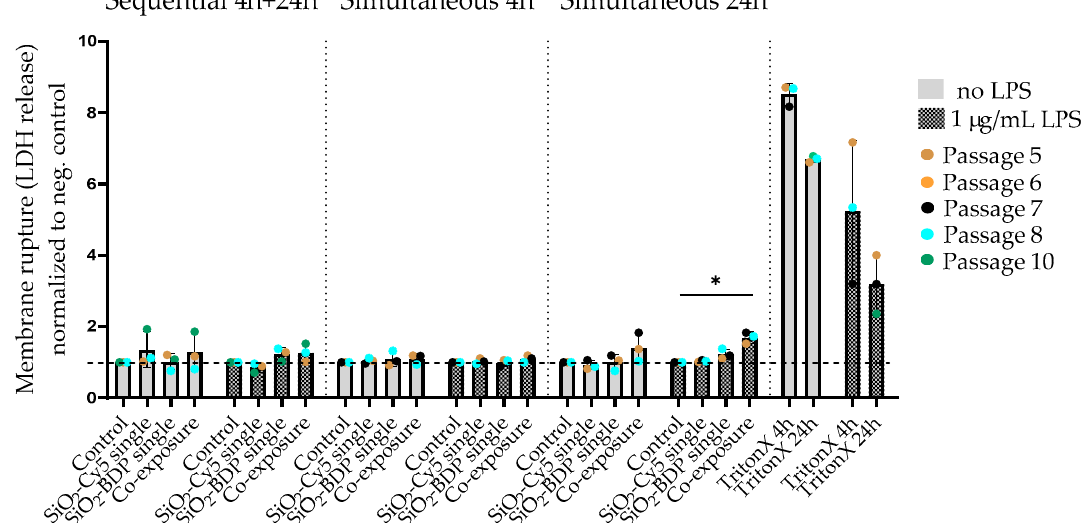
Figure 3. Cytotoxicity of LPS and SiO 2 particles, determined by lactate dehydrogenase (LDH) assay. J774A.1 macrophages were prestimulated with 1-µg/mL LPS for 24 h and post-treated with a single particle type or used for sequential or simultaneous co-exposure. As a control, supernatants from non-LPS-stimulated cells were analyzed. Data was normalized to the negative control (dotted line) and expressed as a fold increase in LDH release over the negative controls. TritonX (0.2%) served as a positive control for membrane rupture. One-way ANOVA (GraphPad Prism) was used for the statistical significance analysis (* p < 0.05).